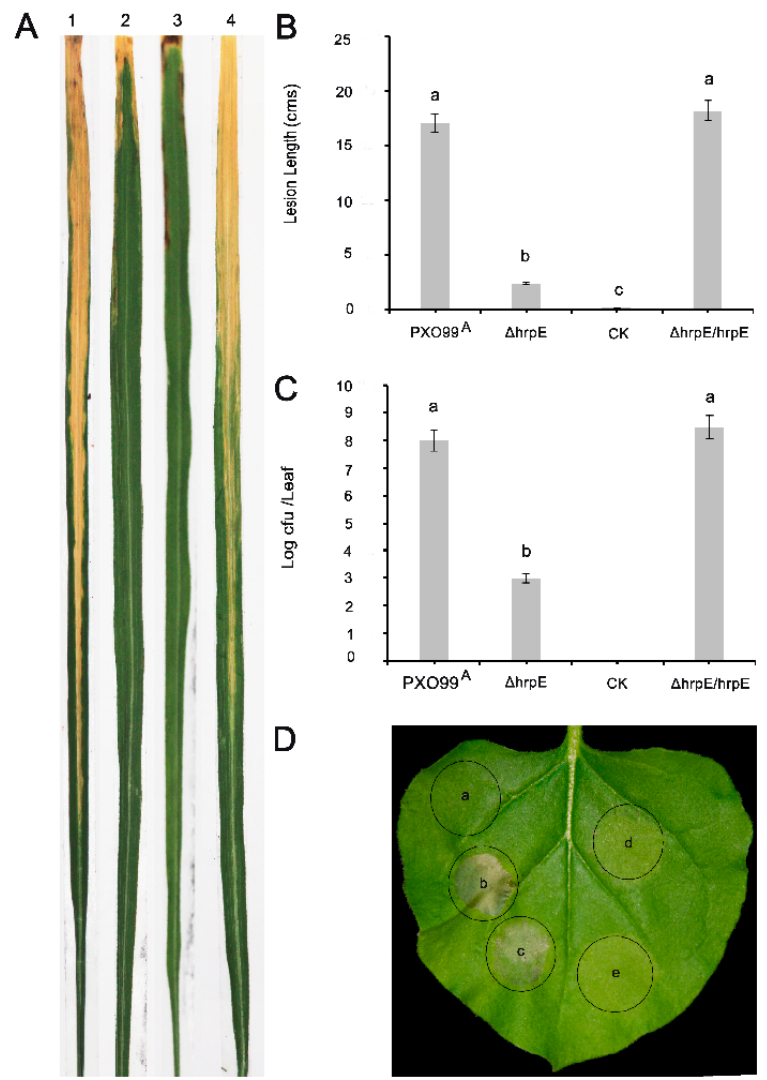
Figure 3 . Deletion of the hrpE gene reduces the virulence of Xoo strain PXO99 A in Nipponbare. Symptoms of the bacterial blight on rice leaves after 15 days of leaf-top-clipping on Nipponbare rice; 1. Symptoms of the bacterial blight on rice leaves after 15 days of leaf ‐ top ‐ clipping on Nipponbare rice; PXO99 A 2. ∆ hrpE 3. CK (water) 4. ∆ hrpE / hrpE ( A ). Lesion length of bacterial blight symptoms of the 1. PXO99 A 2. Δ hrpE 3. CK (water) 4. Δ hrpE/hrpE ( A ). Lesion length of bacterial blight symptoms of the